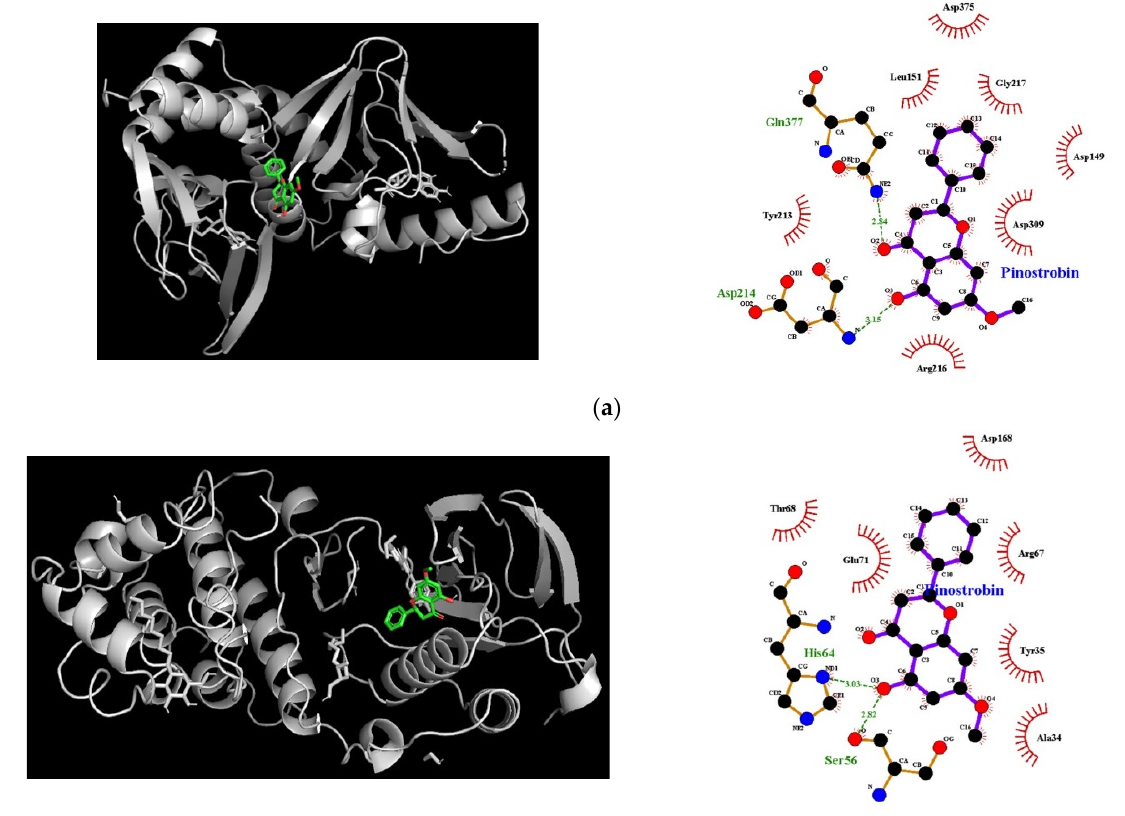
Figure 8. Molecular docking interactions of pinostrobin with ( a ) PKA and ( b ) p38; surface view, and interaction map, such as hydrogen (dotted line in green) and hydrophobic bonding (red dashed semicircle) between pinostrobin with upstream targets involved in melanogenesis.